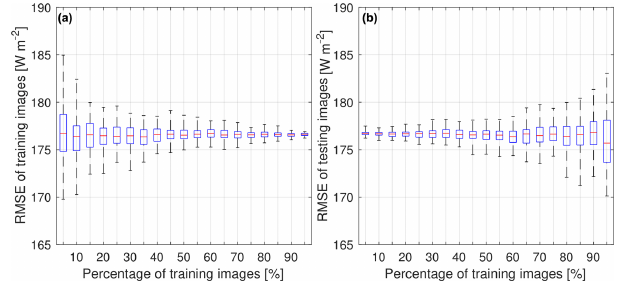
Figure 11. Effect of the percentage of training images on RMSE values. We plot the (a) performance on the training set and the (b) performance on the test set. The lower and upper end of each box represents the 25th and 75th percentiles of the data, and the red line represents the median. Each experiment is conducted 100 times with a random choice of training and test sets.